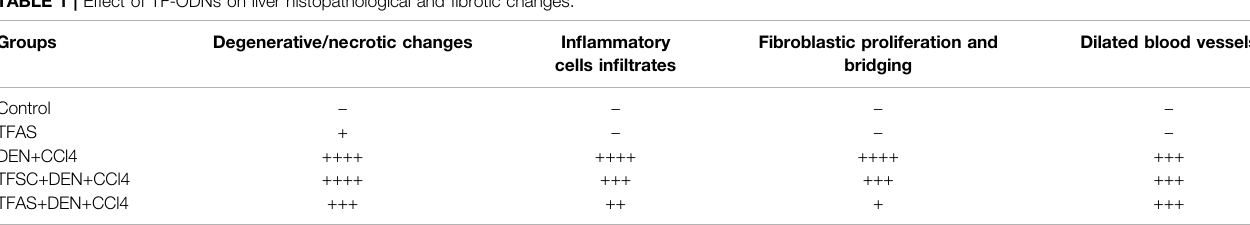
TABLE 1 | Effect of TF-ODNs on liver histopathological and fi brotic changes. Groups Degenerative/necrotic changes In fl ammatory